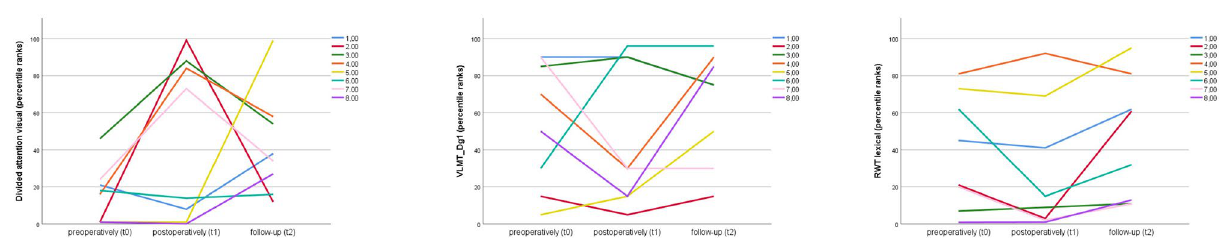
Figure 2. Plots for the 8 meningioma patients in selected subtests of the attention (left), memory (middle), and executive functions (right) categories.